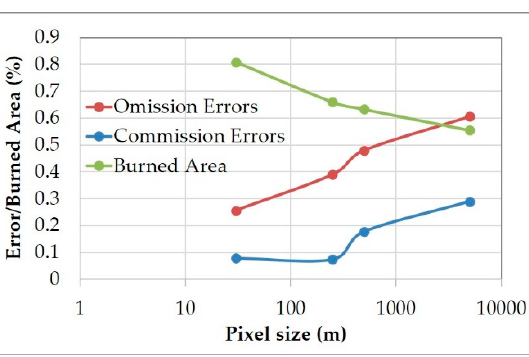
Figure 4. Average percentage of burned area (%) and commission and omission errors (%) versus the spatial resolution (pixel size in meters). The horizontal axis is represented on a log scale.